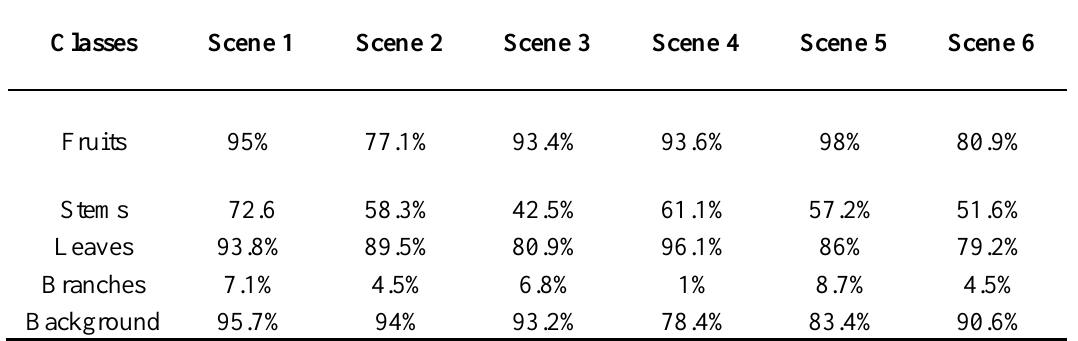
Table 4. Precisions for each class and for each scene obtained with the proposed approach.